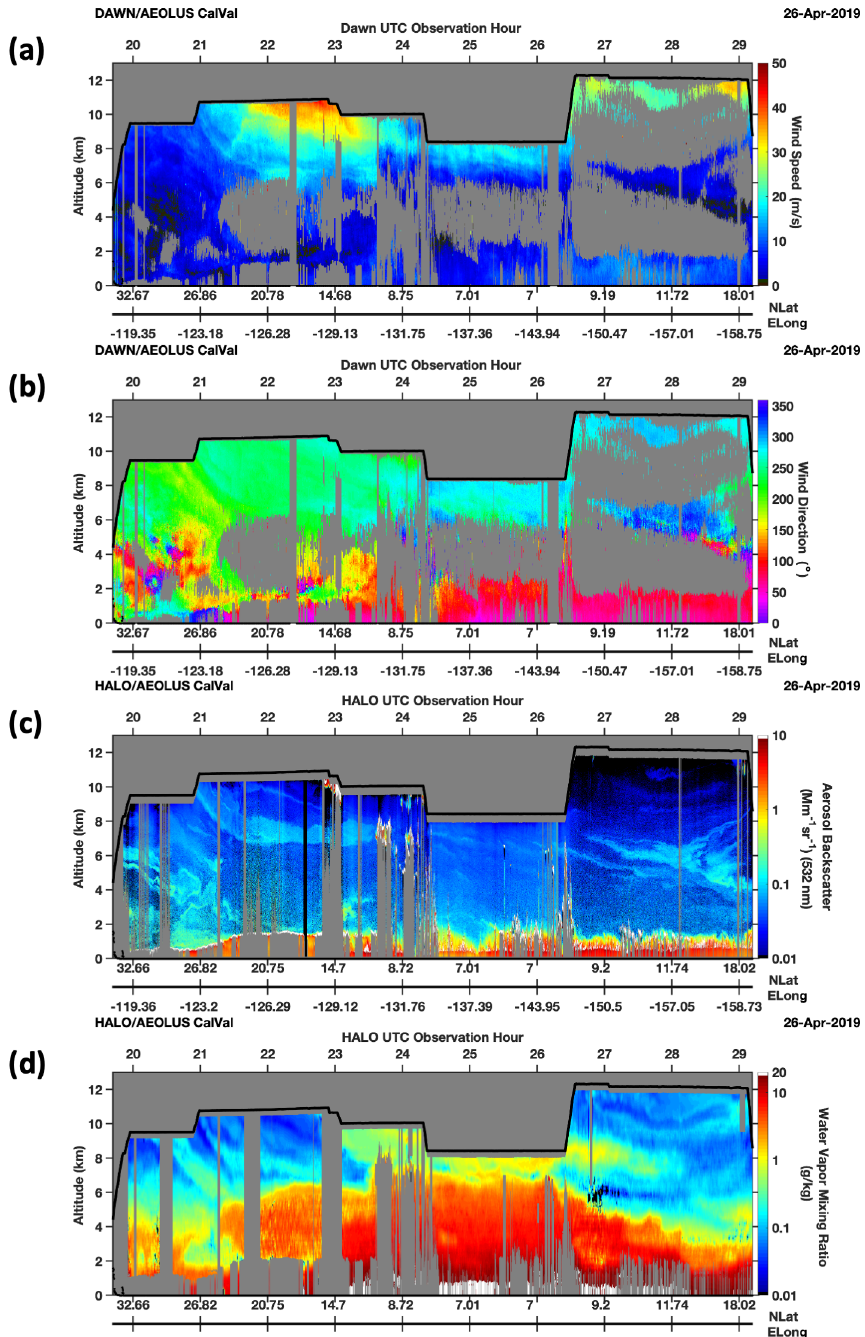
Figure 9. The same as Fig. 6 except for the 25 and 26 April 2019